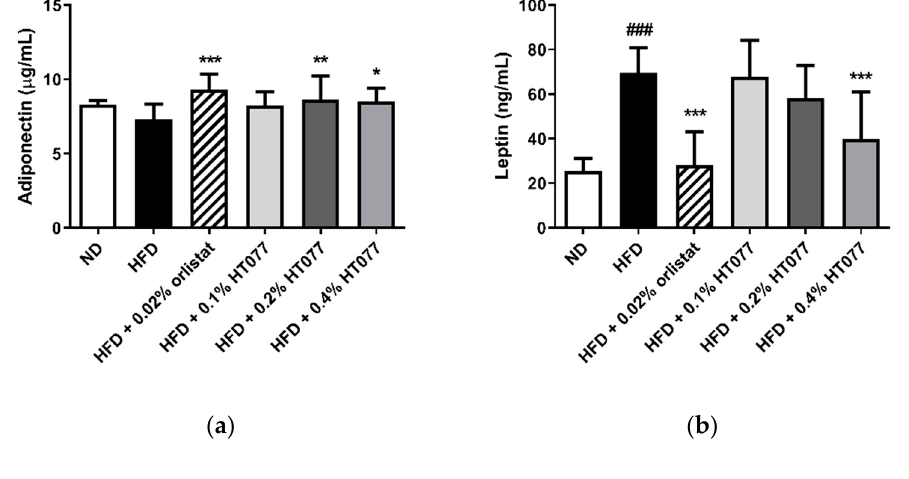
( f ) Figure 3. Effects of an extract mixture of Prunus persica and Nelumbo nucifera (HT077) on serum biochemical profiles in C57BL/6 mice fed a high-fat diet (HFD). The levels of glucose ( a ), triglycerides